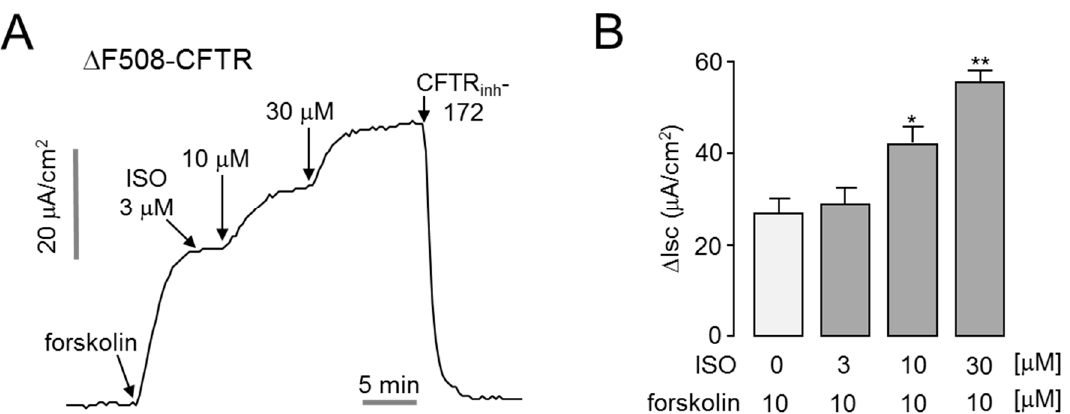
Figure 4. Isorhamnetin potentiates low-temperature-rescued ∆ F508-CFTR. ( A ) Apical membrane current was measured in FRT cells expressing human ∆ F508-CFTR. ∆ F508-CFTR was rescued by low-temperature (27 ◦ C) incubation for 24 h. Where indicated, forskolin, isorhamnetin, and CFTR inh -172 were added. ( B ) Summary of apical membrane current increases ( ∆ Isc, mean ± S.E., n = 3–4). * p < 0.05, ** p <